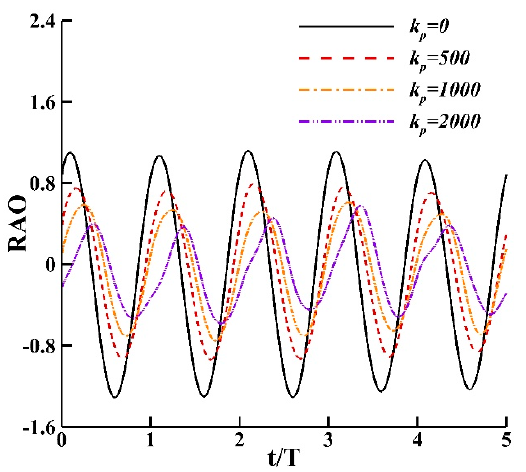
Figure 19. Time histories of buoy heaving under various PTO damping effects ( H = 0.1 m, T = 1.75 s).